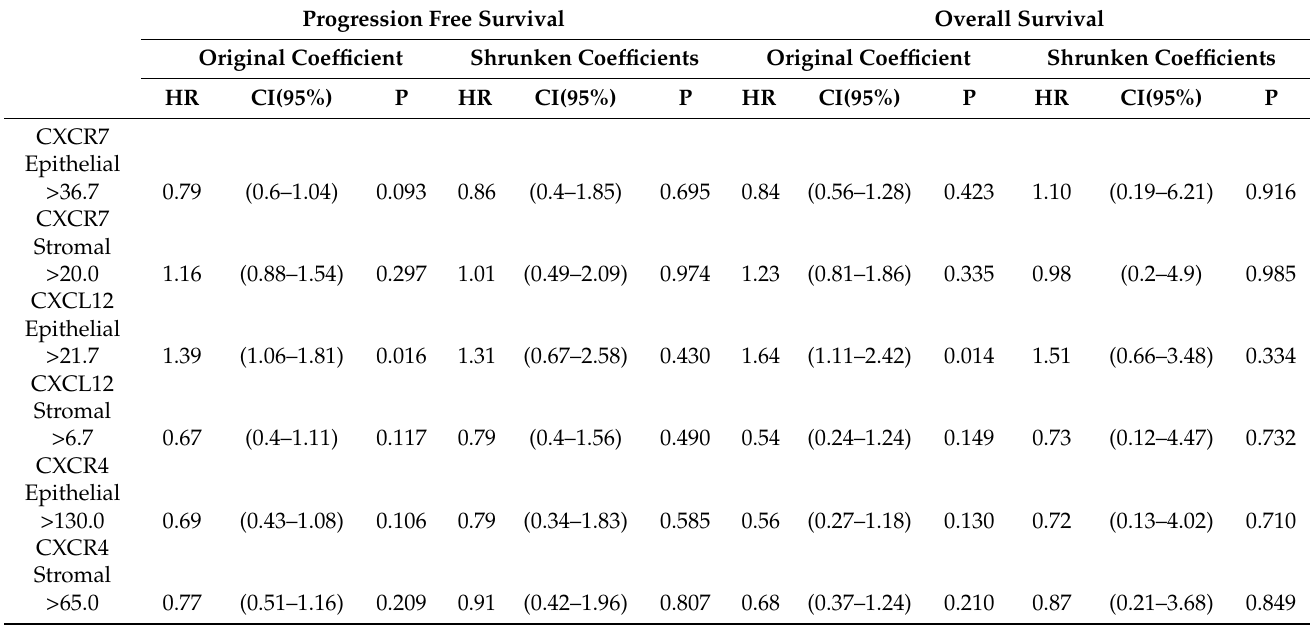
Table 2. Univariate analysis of biomarkers best cut-off for PFS and OS, original and shrunken